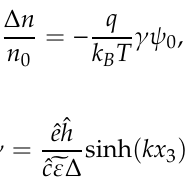
Figure 8. Polarization-induced charge distributions for di ff erent n 0 when ψ 0 = 10 − 4 AT. ( a ) E ff ective polarization charge, ( b ) electron concentration perturbation.